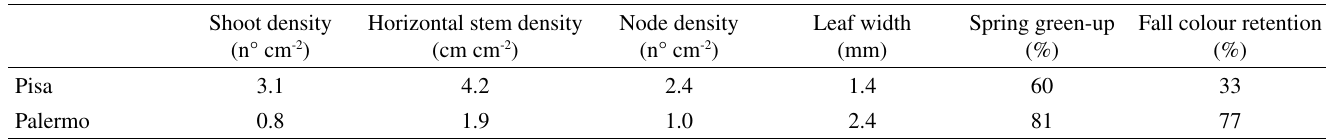
Spring green-up (%)